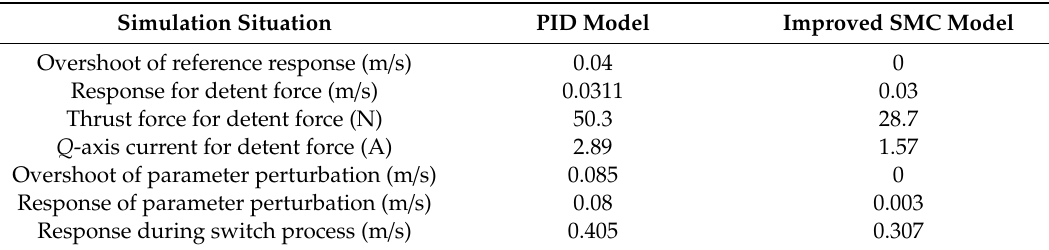
Table 2. Simulation performances of segmented PMLSM with proportional-integral-derivative (PID) and improved SMC model.